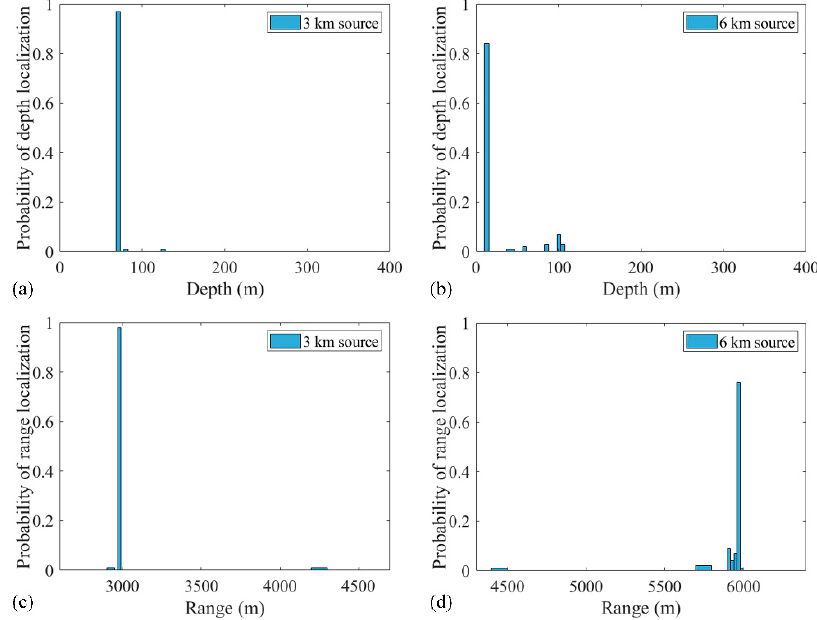
Figure 13. ( a , b,c ) Ambiguity surfaces generated by different realizations with 28 snapshots and a 32 element VLA using the RAMPMF method to localize sources (3 km, 70 m) and (6 km, 10 m). True source positions and the positions estimated by the RAMP and RAMPMF methods are represented as black asterisks, squares, and inverted triangles, respectively.